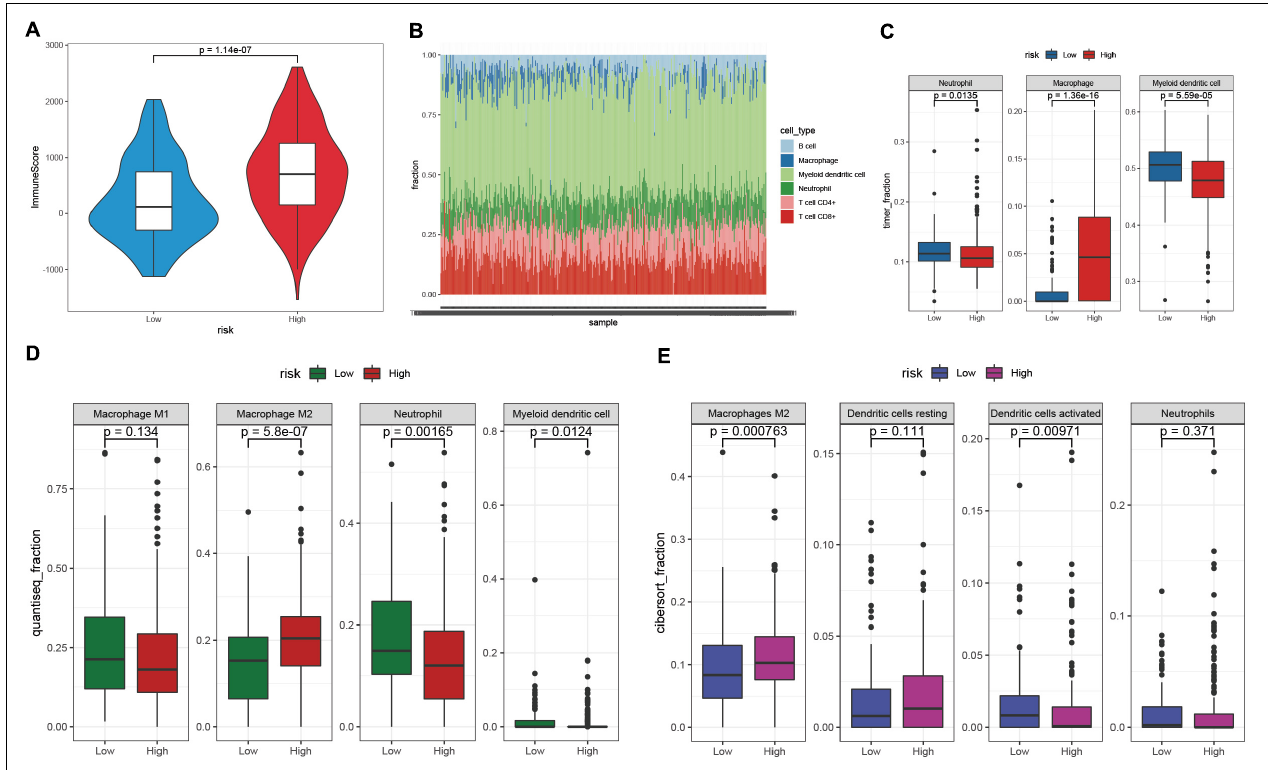
FIGURE 8 | Investigation of the TIME between the low- and high-risk groups. (A) The immune score of the high-risk group was higher than that of the low-risk group. (B) The landscape of tumor-infiltrating cells of STAD samples. (C–E) The fractions of tumor-infiltrating cells between the low- and high-risk groups were estimated by TIMER (C) , quanTIseq (D) , and CIBERSORT (E)